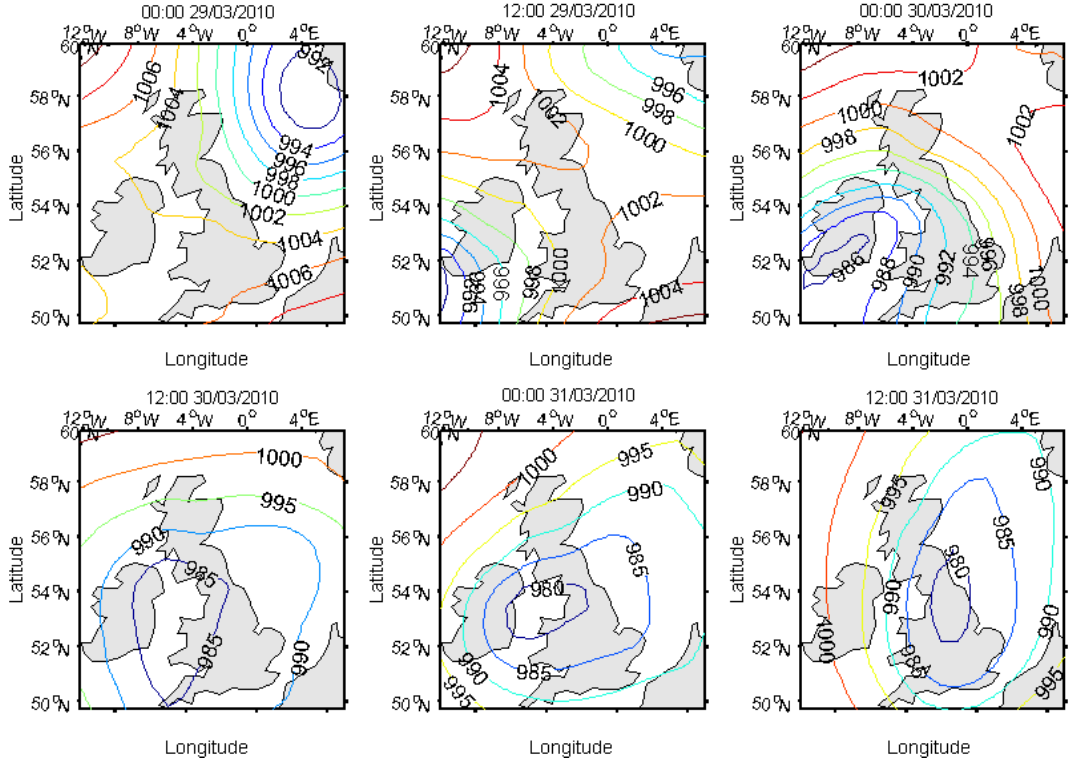
Figure 11. The mean sea level pressure fields (hPa) before and during the 30–31 March 2010